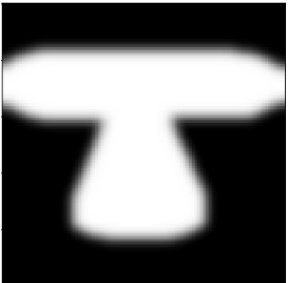
Figure 5. Large-scale facial expression dataset map. In a real-world scene, the position of the face is not fixed. Some faces are located in the center of the picture, whereas some faces are located at the corner of the picture. The pose of the face is uncertain, including 30 ◦ , 45 ◦ , and 90 ◦ faces. Some faces are blocked, not all facial features can be seen, and the image is unclear, which makes facial expression recognition difficult.